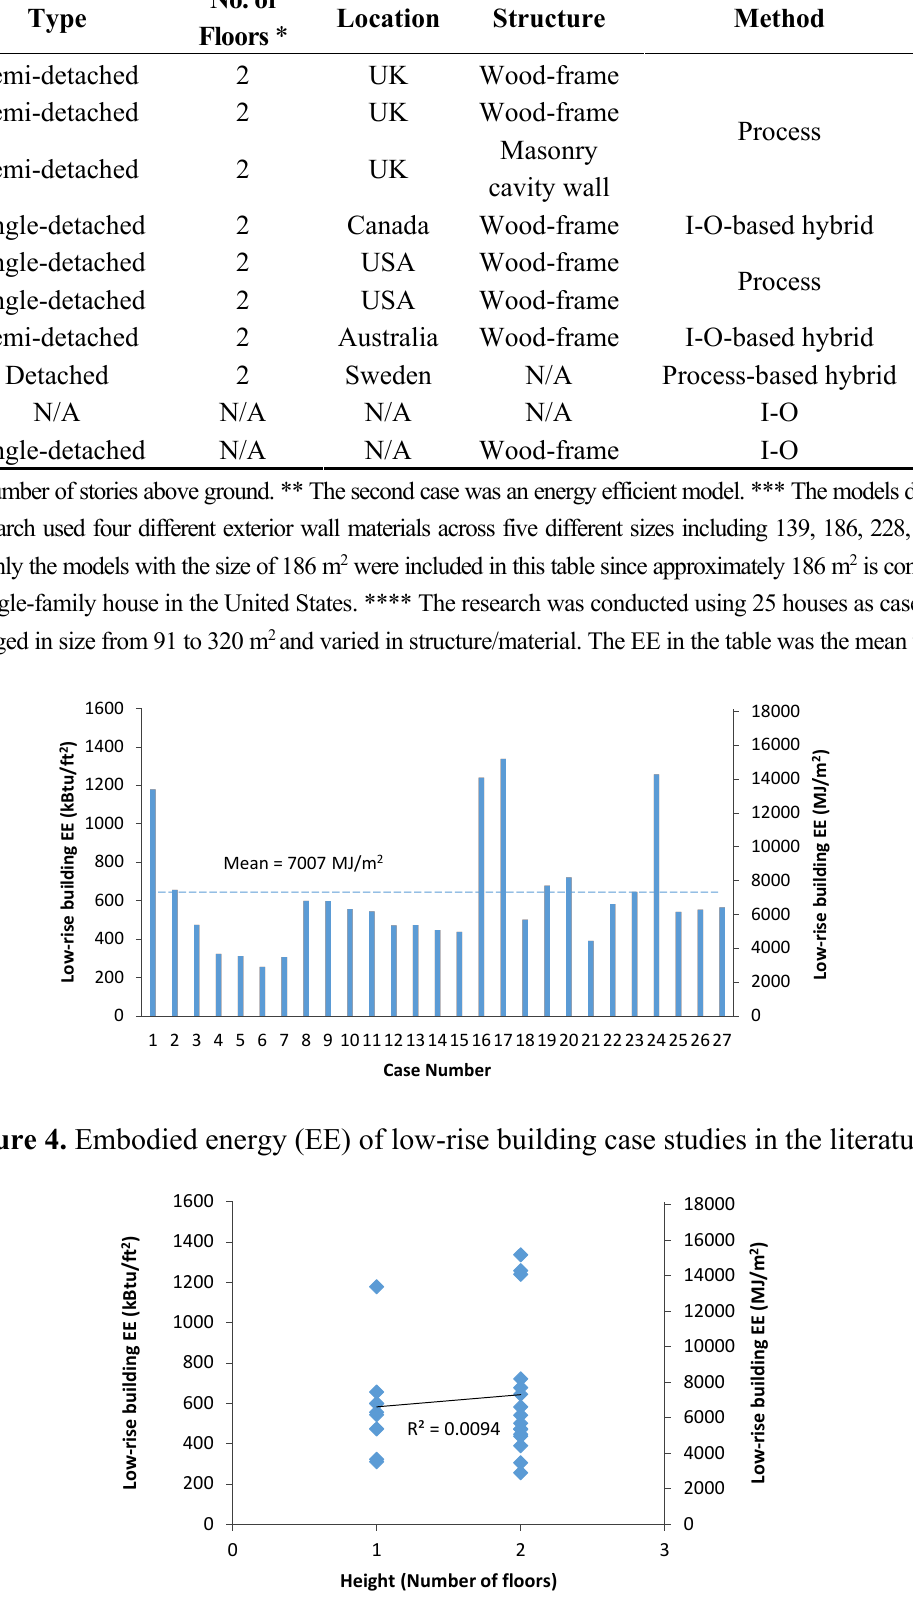
Figure 5. Correlation between embodied energy (EE) and building height for low-rise case studies in the